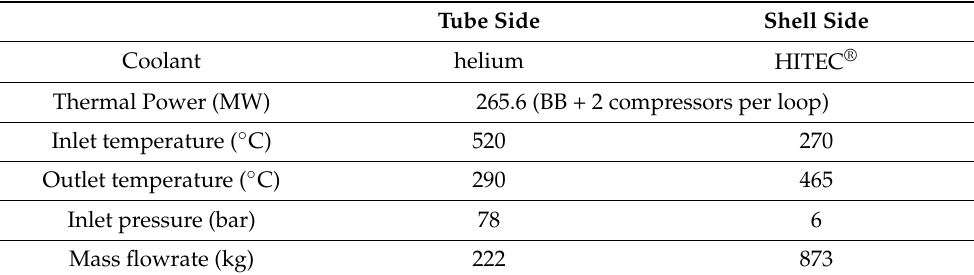
Table 6. Characteristics of the IHX for DEMO HCPB ICD